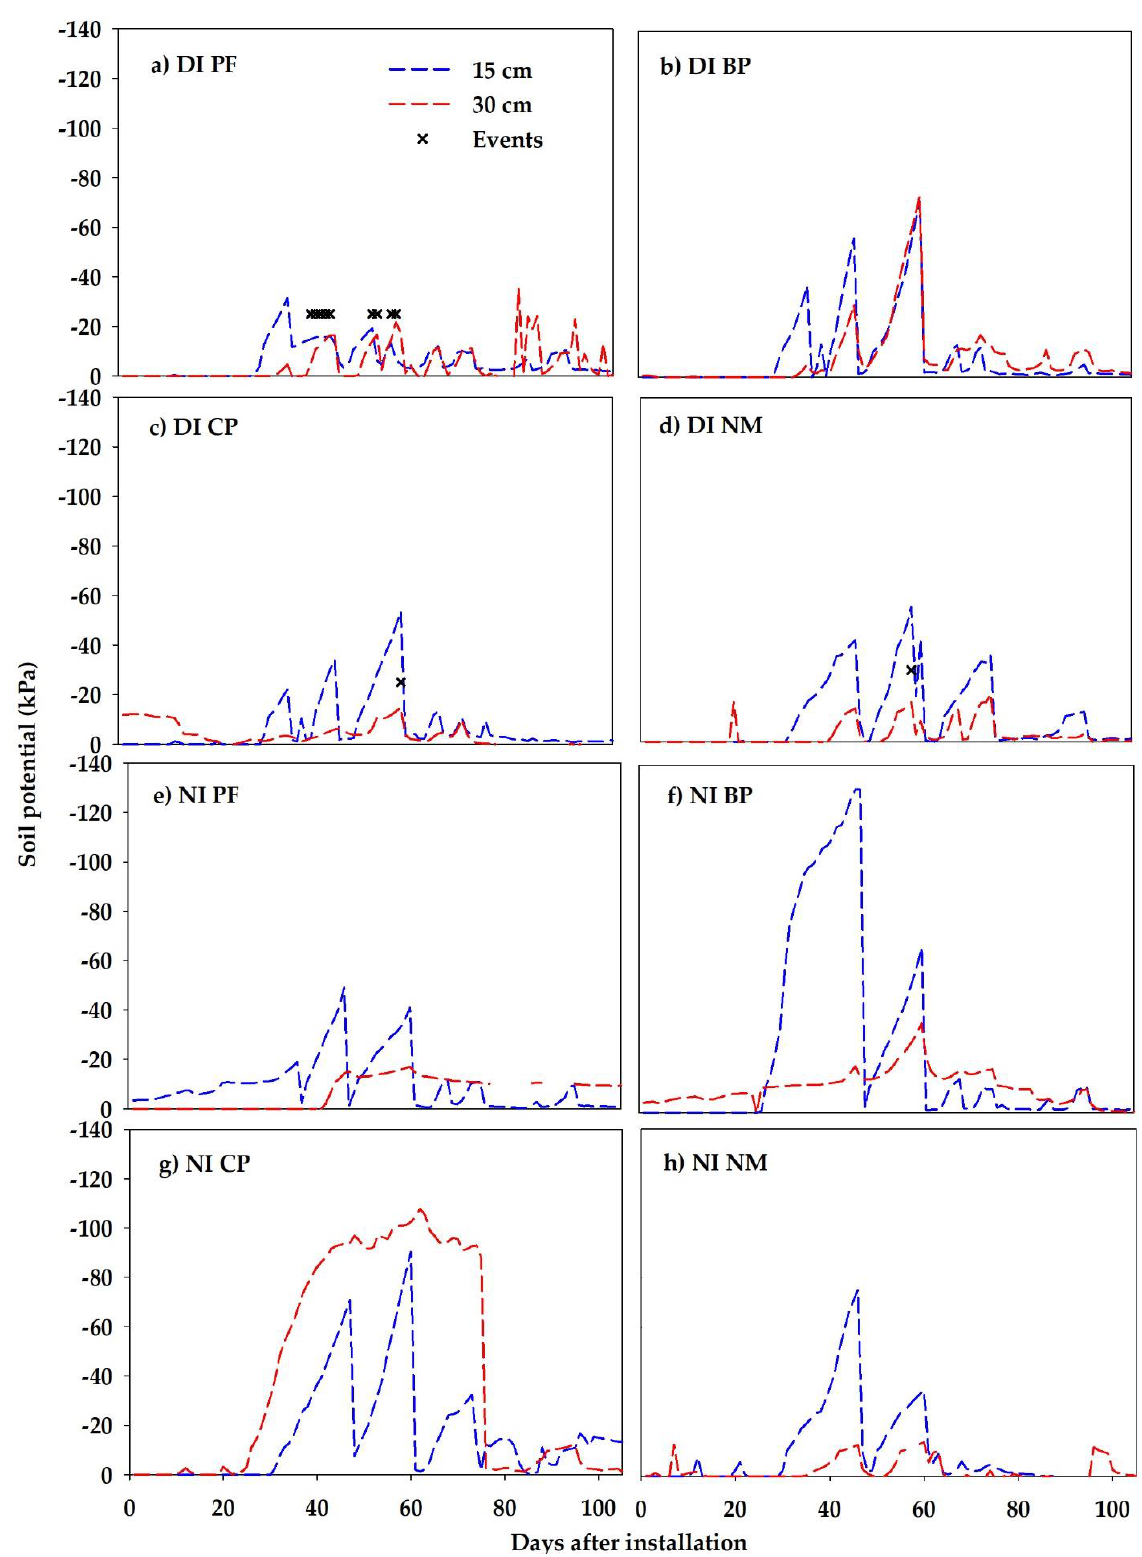
Figure 5. Daily average soil matric potential (08:00 am) at 15 and 30 cm deep in watermelon plots during 2019 field experiment under drip irrigation (DI) treatment with ( a ) landscape fabric mulch (DI PF), ( b ) black plastic mulch (DI BP), ( c ) clear plastic mulch (DI CP), ( d ) no mulch (DI NM), and no irrigation treatment (NI) with ( e ) landscape fabric mulch (NI PF), ( f ) black plastic mulch (NI BP), ( g ) clear plastic mulch (NI CP), and ( h ) no mulch (NI NM).